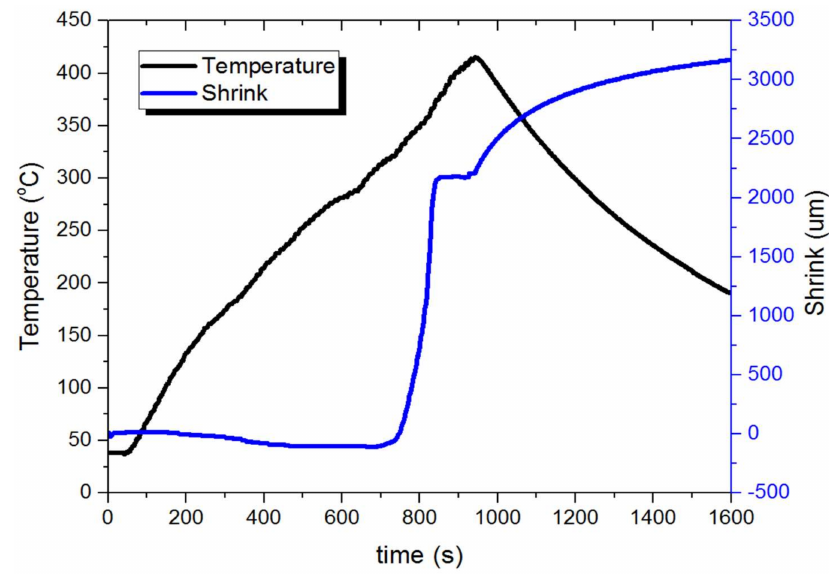
Figure 5. Punch displacement curves for 60 s sintering time.